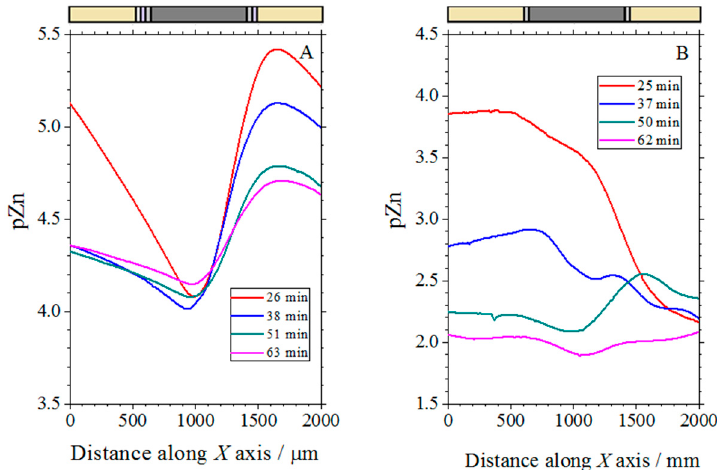
Figure 12. Line scans recorded with the Zn ISME above the cut edge of galvanized steel samples immersed in 1 mM NaCl solution. ( A ) Complete coil-coated system with organic layers of different thickness at each side (corresponding to sketch #1 in Figure 1C); ( B ) coil-coating system after removing the organic coatings at each side (corresponding to sketch #2 in Figure 1C). The lines were recorded from the left to the right.